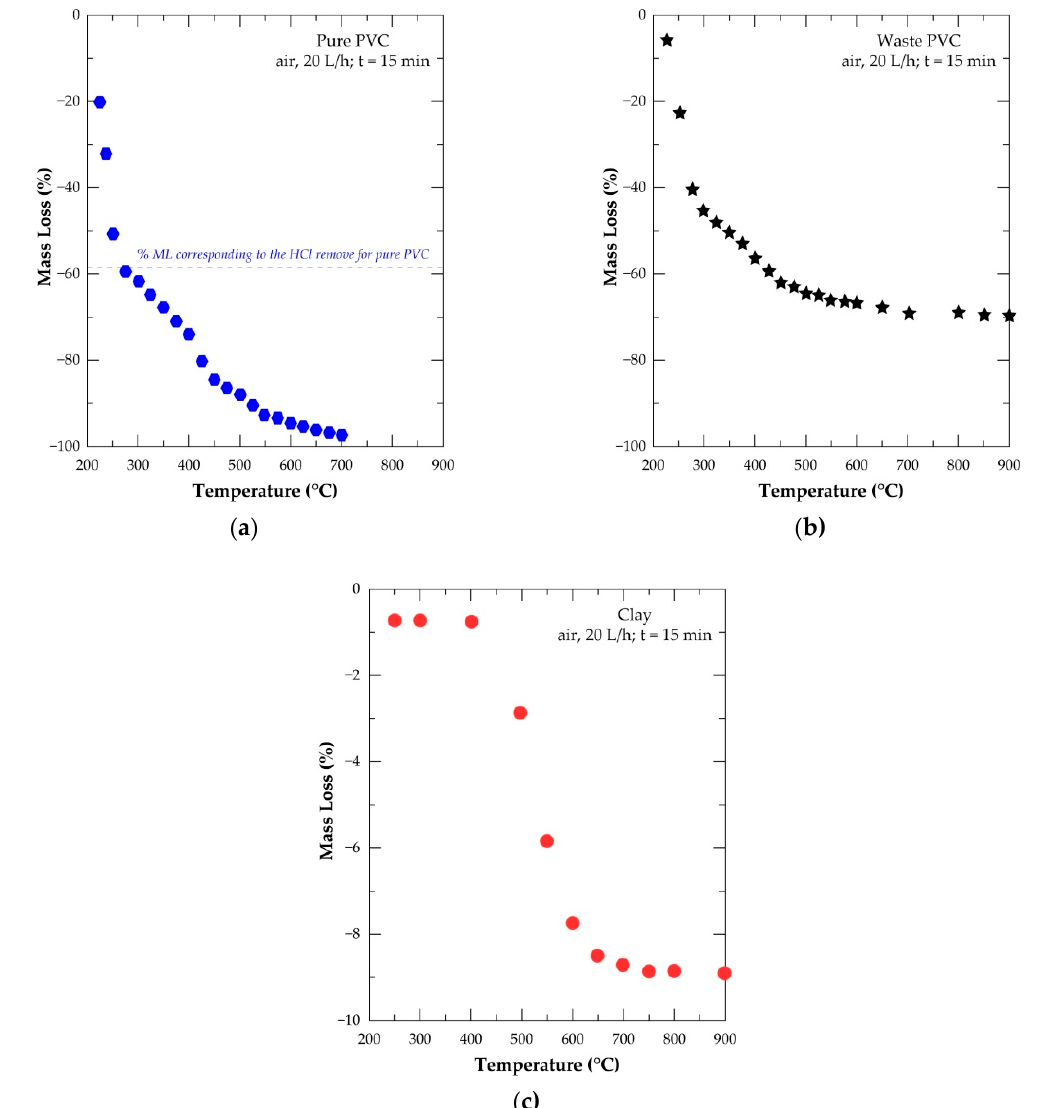
Figure 7. The mass change of the samples versus the temperature for the treatment of samples in air from 200 °C to 900 °C at 15 min: ( a ) pure PVC; ( b ) PVC waste; and ( c ) clay.